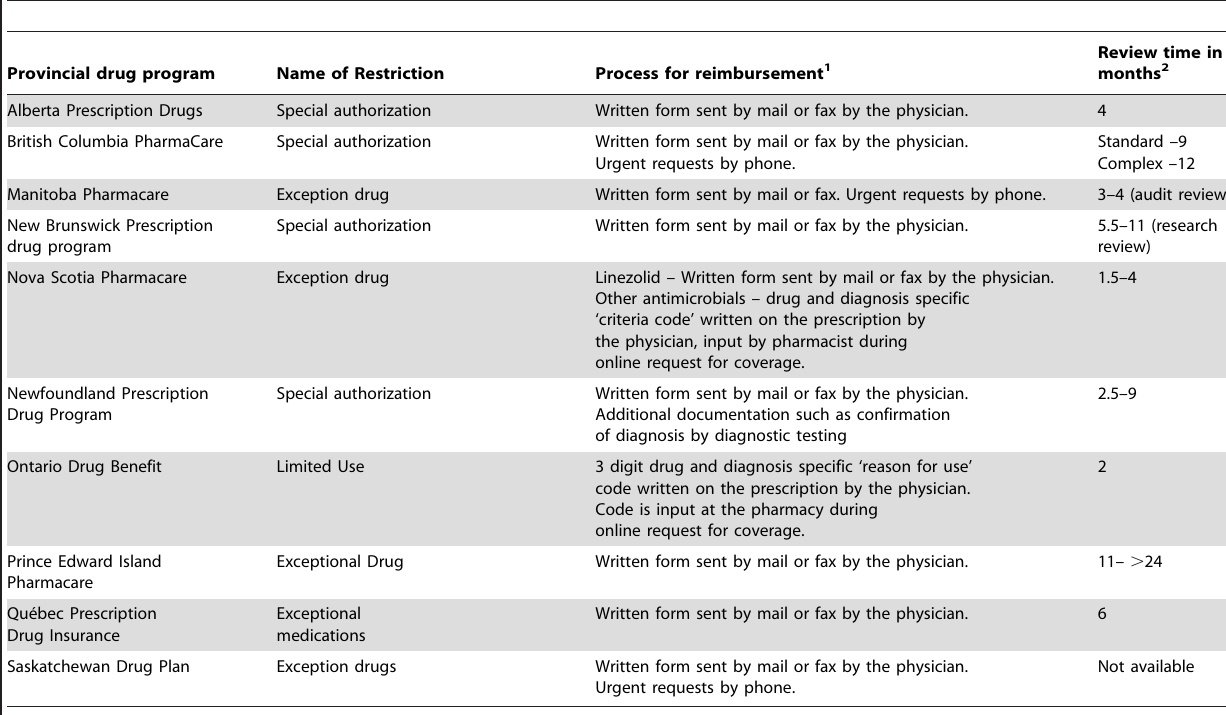
Table 2. Summary of provincial drug plan restrictions, criteria for reimbursement, and the lag time from Common Drug Review approval to provincial decision in Canadian